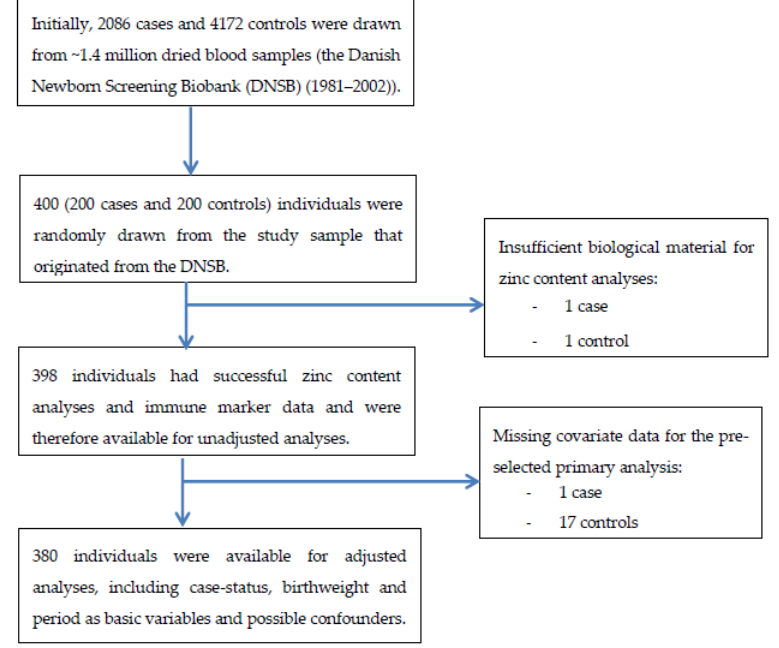
Figure 1. Flow chart of participants included in the study and di ff erent